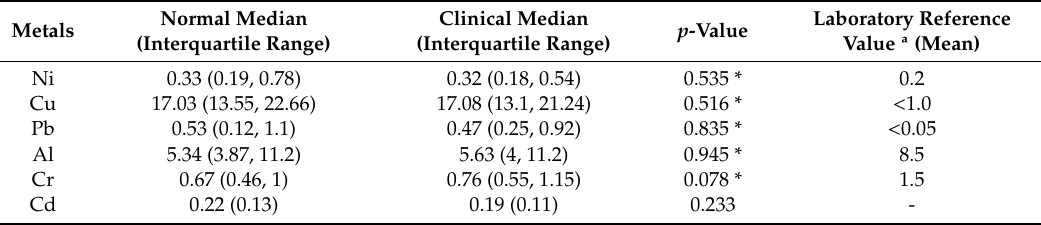
Table 2. Median (interquartile range) of toenail heavy metal concentrations ( µ g / g) by child behavior checklist (CBCL) behavior outcomes.